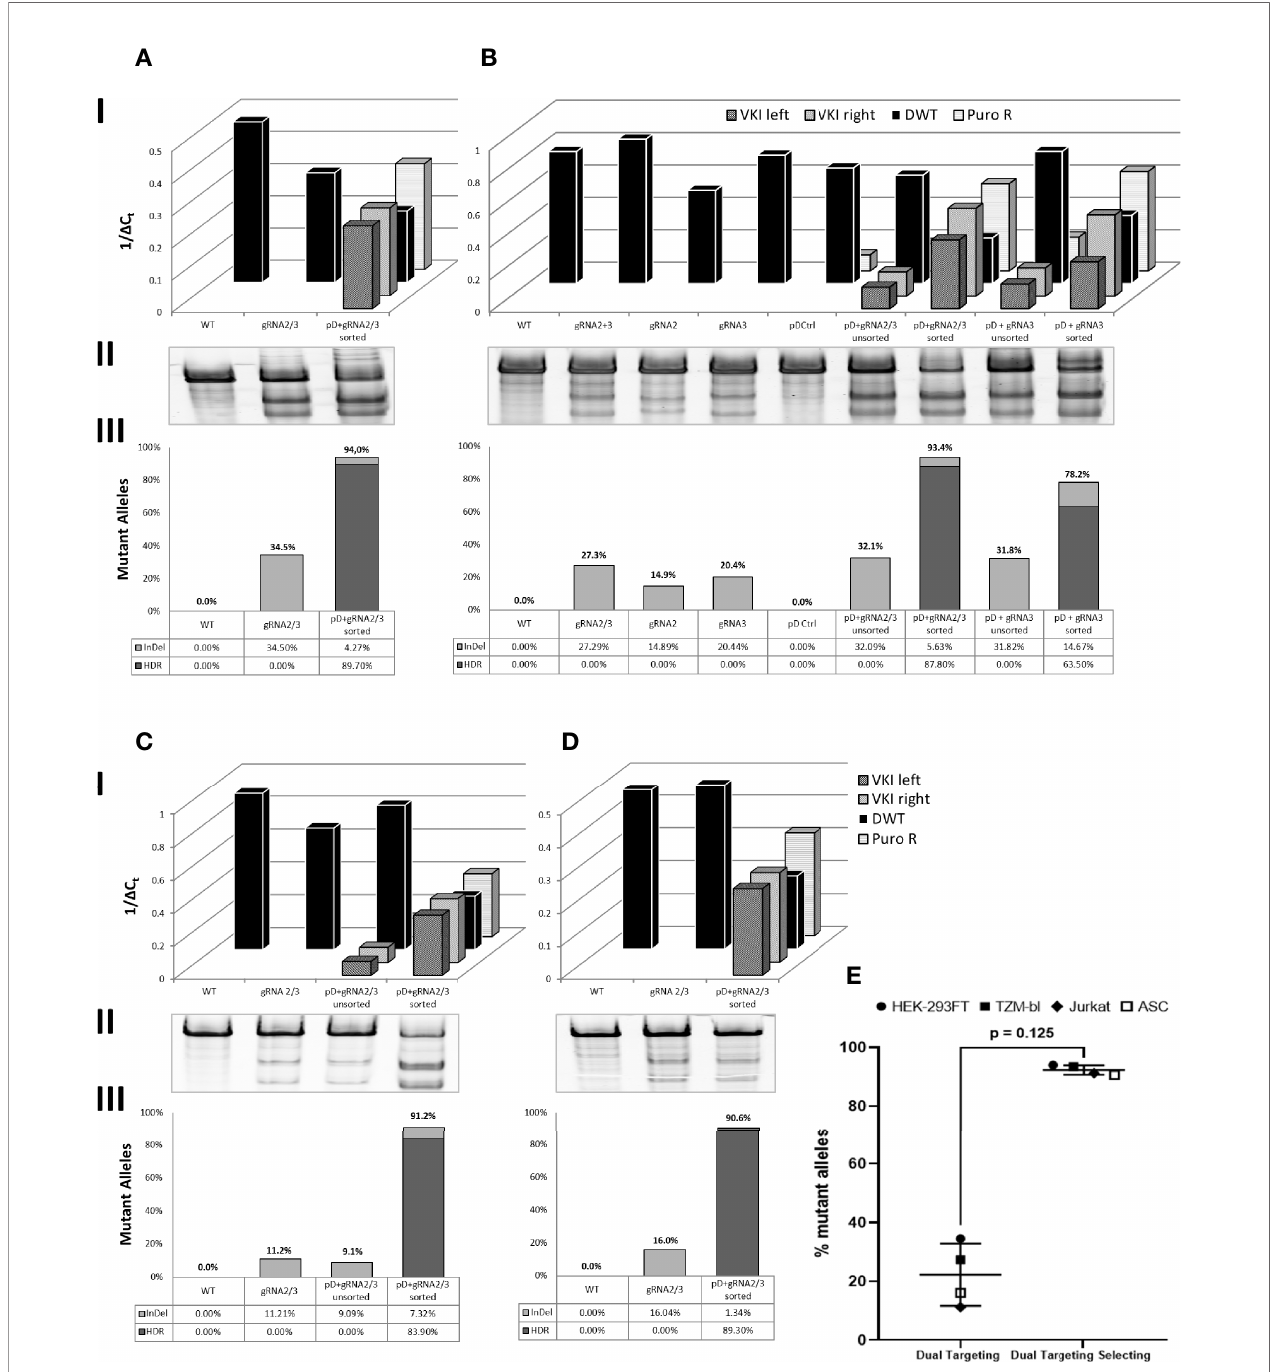
FIGURE 3 | Quantitative analysis of genomic changes in target site. Dually targeted and selected cells (pD + gRNA2/3 sorted) were compared to WT and cells dually targeted with gRNA2/3. Additionally the genomic pro fi le of targeted populations before sorting for dual positivity (pD+gRNA2/3 unsorted) was analyzed in (B, C) B also includes comparison groups targeted and target-selected with single gRNAs. I: Real Time quantitative PCR of total PSM (PuroR), the integrated PSM (VKI left/right) and the CCR5 Locus not carrying a knock-in (DWT). qPCR r esults are presented inversely (1/ D C t ), so a high and a low genomic load are represented by a tall and a low bar respectively. II: T7EI-Assay of the DWT Amplicon. III: Calculation of the Fraction of Mutant Alleles, carrying a knock-in (HDR) or an InDel (InDel): [%Mutant Alleles = HDR + ((1-HDR)*InDel)]. [HDR = 1 - DWT]. DWT, the fraction of alleles not carrying a knock-in, is calculated through linear regression of the D Ct (DWT) on the standard curve as described above. InDel frequency was calculated as previously mentioned. (A) HEK 293FT. (B) TZM-bl. (C) Jurkat. (D) ASC. (E) Mean fraction of mutant alleles across all cell types in double positive, dual targeting selecting group (pDonor-EGFP/dTomato + pCas9-gRNA2/3) compared to dual targeted control group (pCas9-gRNA2/3). Error bars show±SD. Statistical analysis was performed using Wilcoxon matched-pairs signed rank